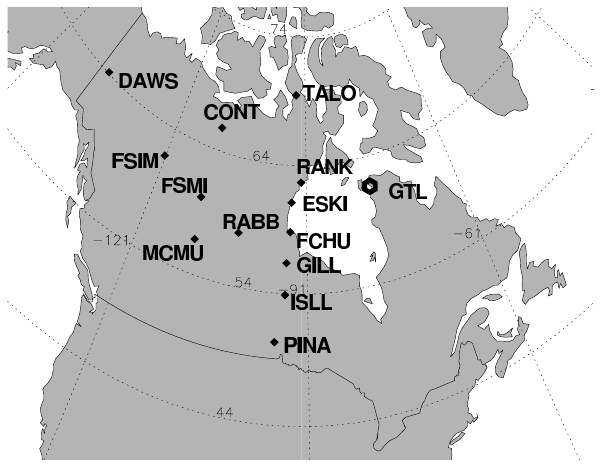
Fig. 2. X -component traces from the Churchill line of CANOPUS magnetometers for 4 February